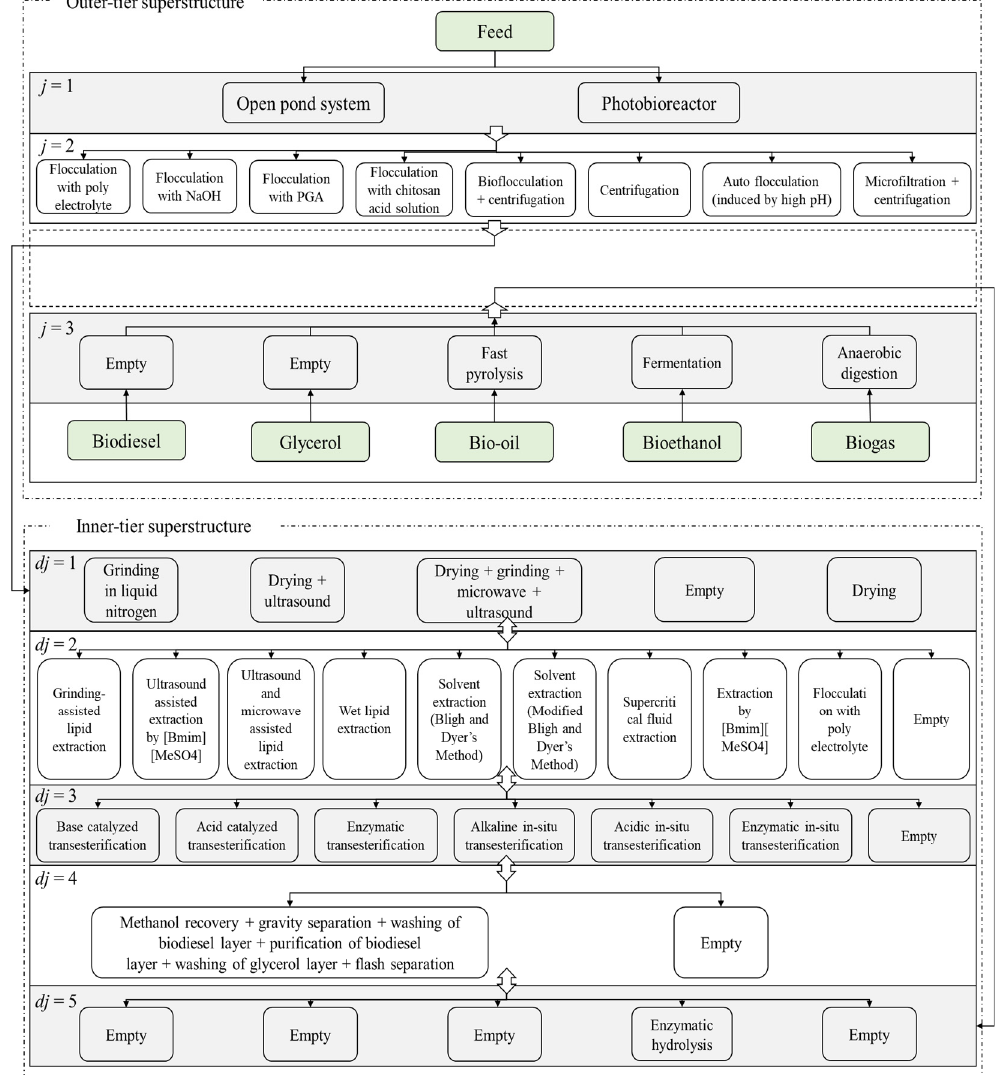
Figure 3. Two-tier superstructure of chemical species and technologies for productions from micro- algae biomass.